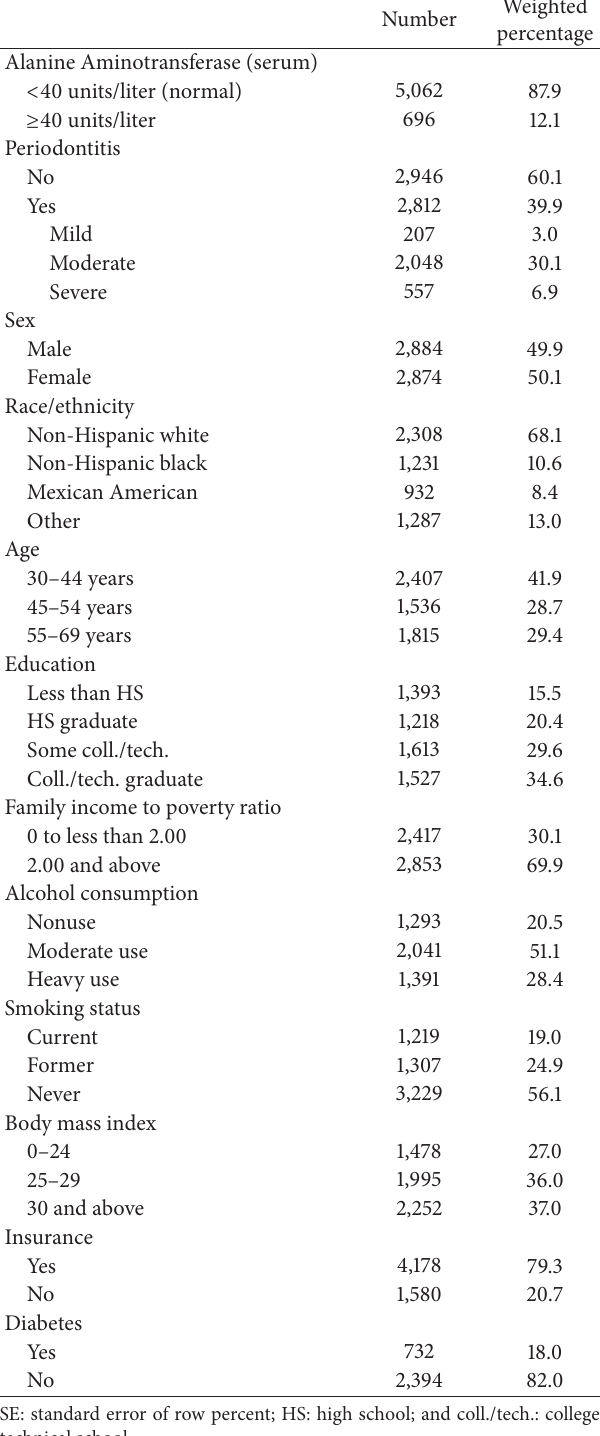
Table 1: Sample characteristics, NHANES 2009–2012, 𝑛 = 5758